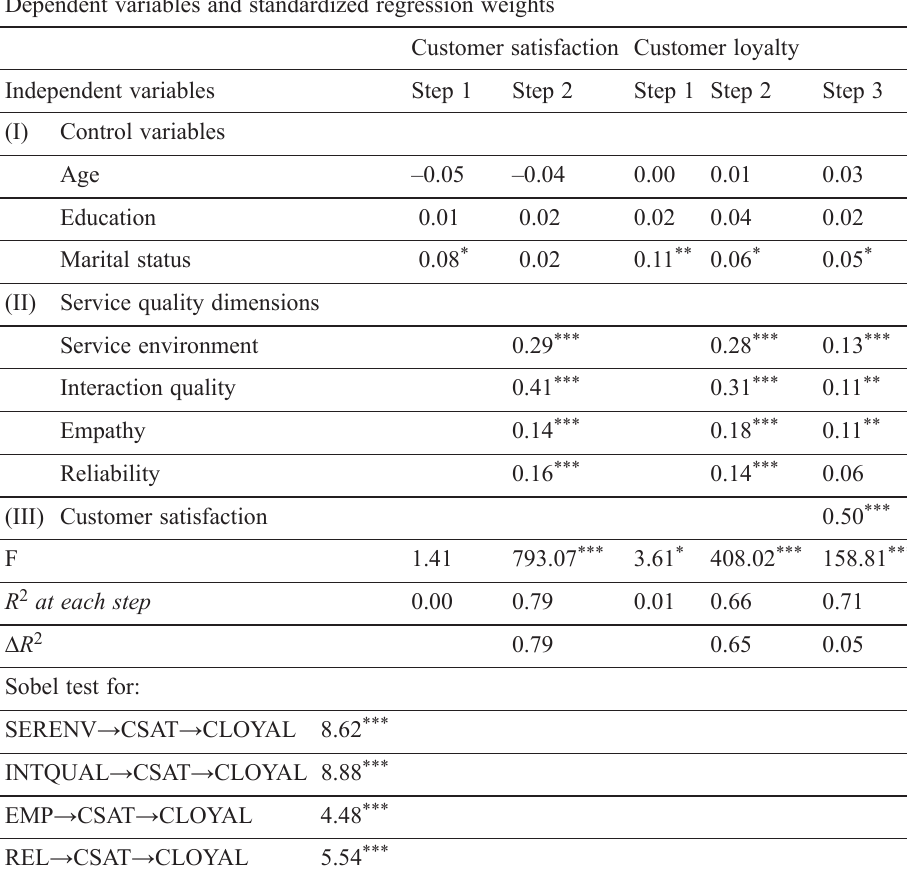
Table 4. Hierarchical multiple regression results: direct and mediating effects Dependent variables and standardized regression